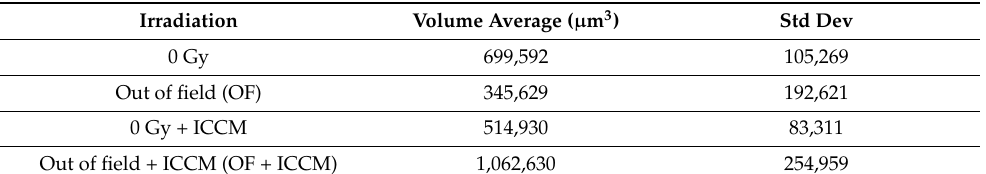
Table 5. Colony volume measurements of PNT1A cell cultures (n = 3) from Shields et al (unpublished data) [5].